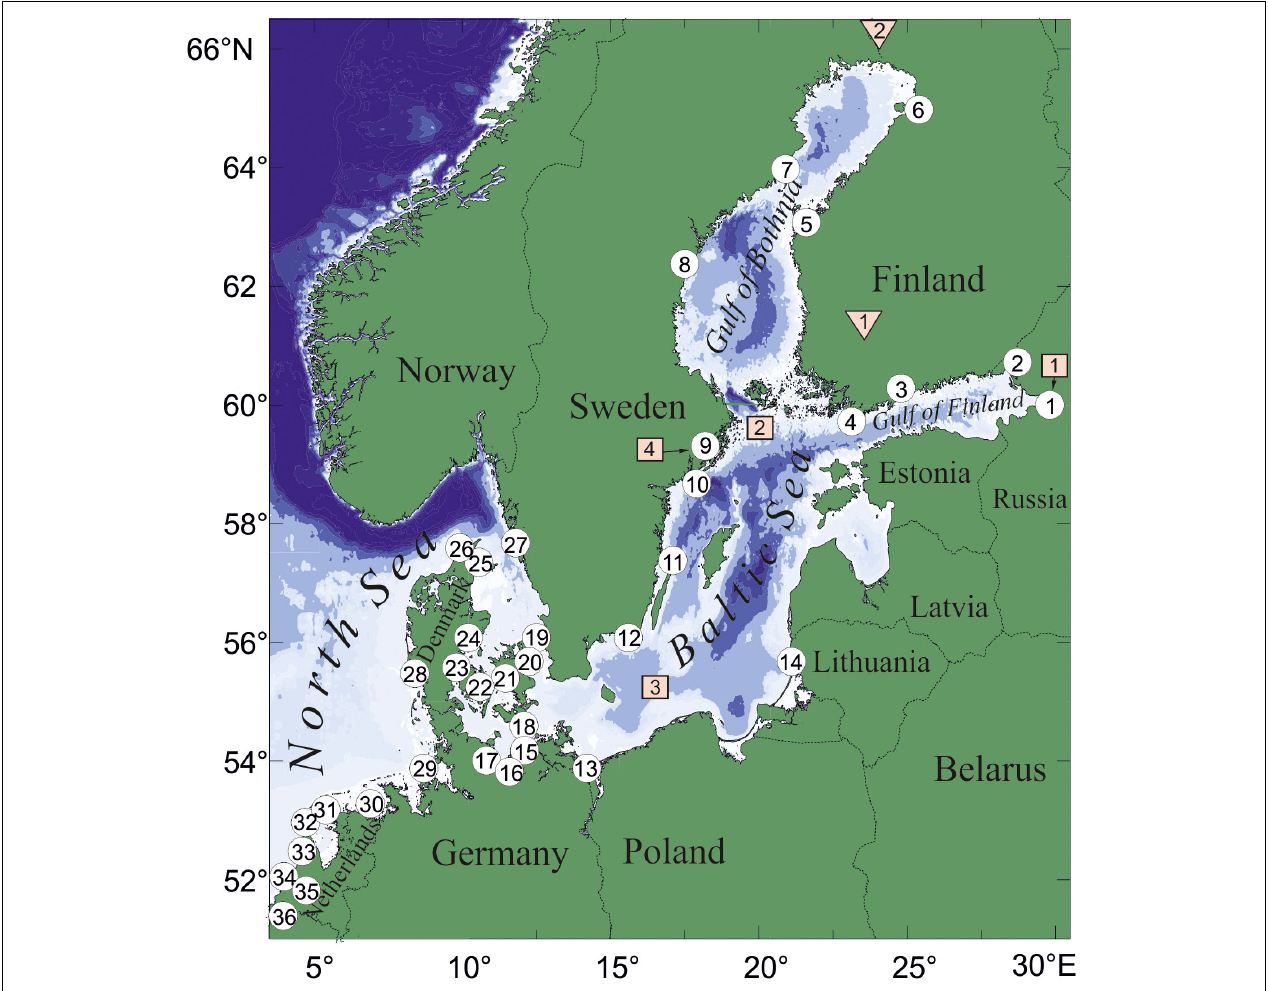
FIGURE 1 | Locations of the tide gauge stations (white circles); the names of the stations are given in Table 1 . The red squares indicate reanalysis grid point locations which were used to analyze (1) the air pressure from the NCEP/NCAR, (2) the air pressure from the ERA-Interim, (3) the air pressure and wind data from the 20th Century Reanalysis, and (4) the air pressure from the NCEP/CFSR. The red triangles show the location of the weather stations: (1) Pirkkala Tampere-Pirkkalan Lentoasema and (2) Pello Kk